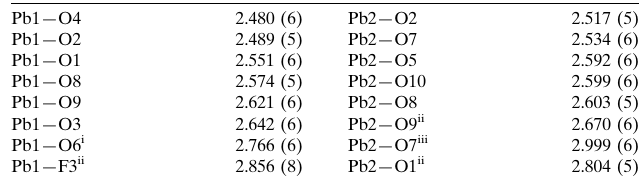
Selected bond lengths (A˚ ).